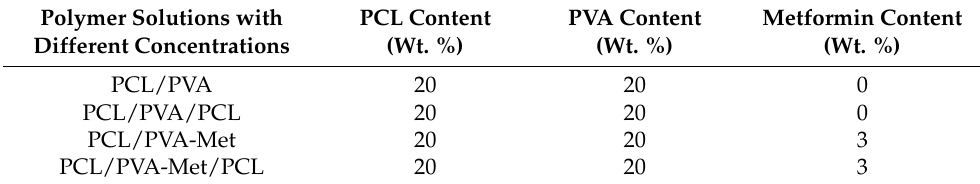
Table 1. Composition of the polymer